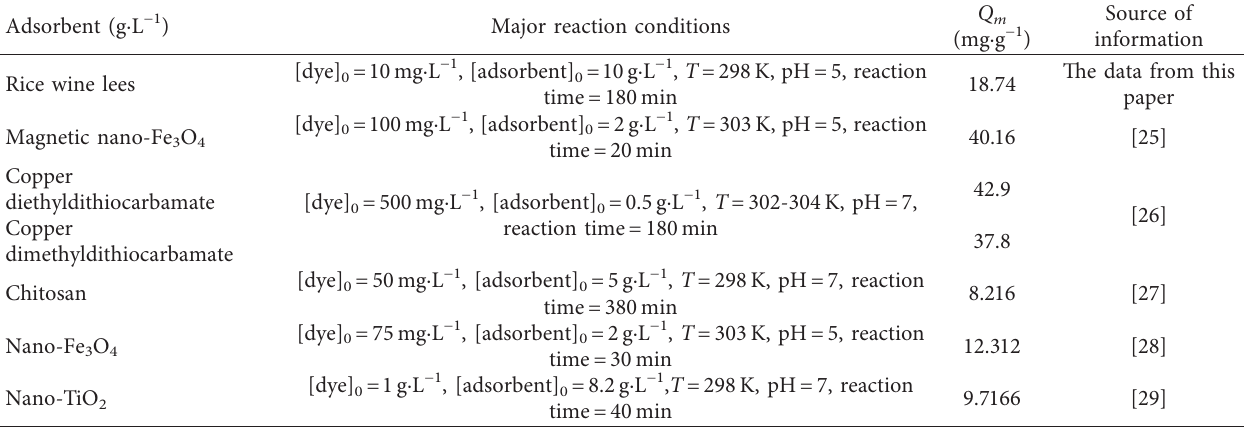
Table 2: Adsorption capacities of various adsorbents for acid red 73.